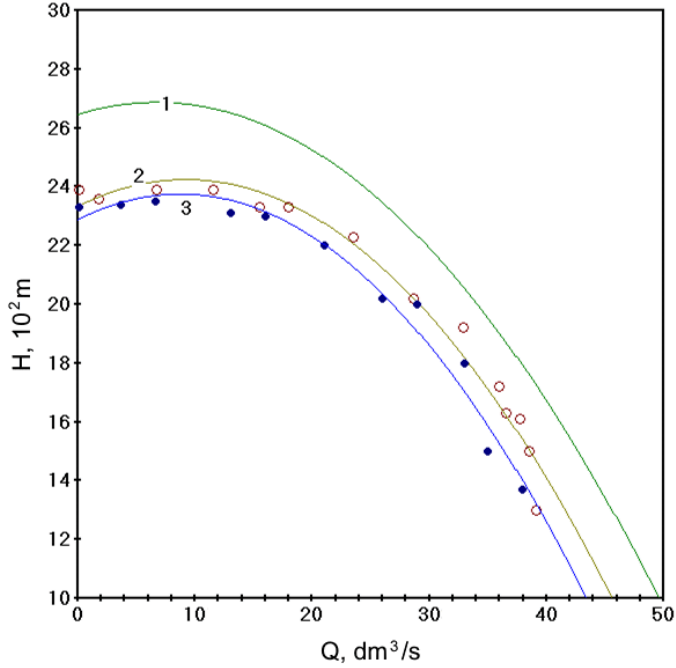
Figure 7. Curves H = f(Q) for water (curve 1) and oils with  = 882 kg/m 3 (curve 2) and  = 888 kg/m 3 (curve 3). ρ = 888 kg/m 3 (curve